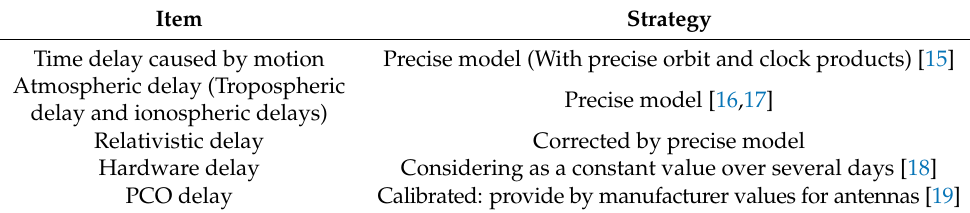
Table 1. Error correction strategies for the two-way time synchronization